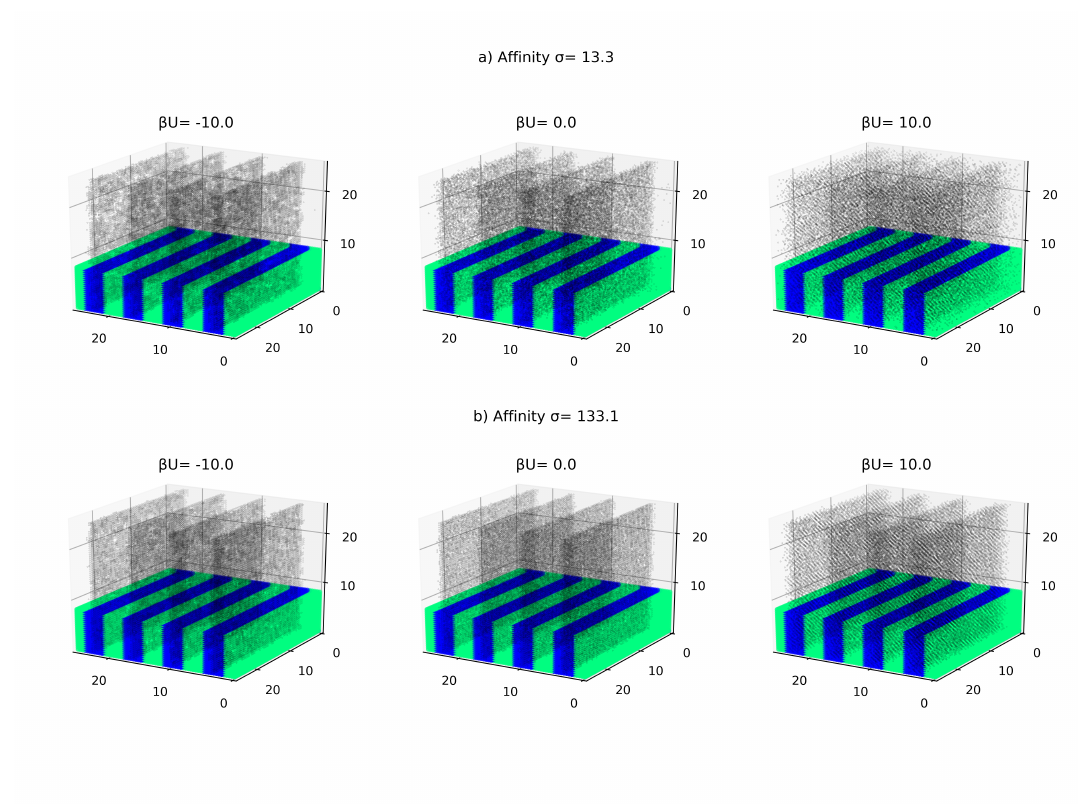
Figure 2. Effect of the interaction between fillers on the dictribution of fillers in the microphase separated DBC system: ( a ) smaller contrast between the affinities of fillers for dissimilar copolymer blocks σ = 13.3; ( b ) larger contrast between the affinities of fillers for dissimilar copolymer blocks σ = 133.1. The volume fraction of particles is φ = 0.15. Black dots show the centers of the filler particles. Selective A phase having larger affinity for polymers is shown in blue, B phase in green. The upper part of the image of the host DBC matrix is cut off to make visible the distribution of fillers inside the DBC system. All lengths are measured in R G